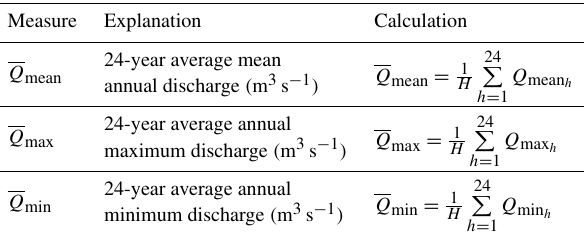
Table 2. Three different discharge measures, Q mean Q min are respectively the mean, maximum, and minimum daily h discharge of year number h , ranging from 1 to 24. The total number of years ( H ) is